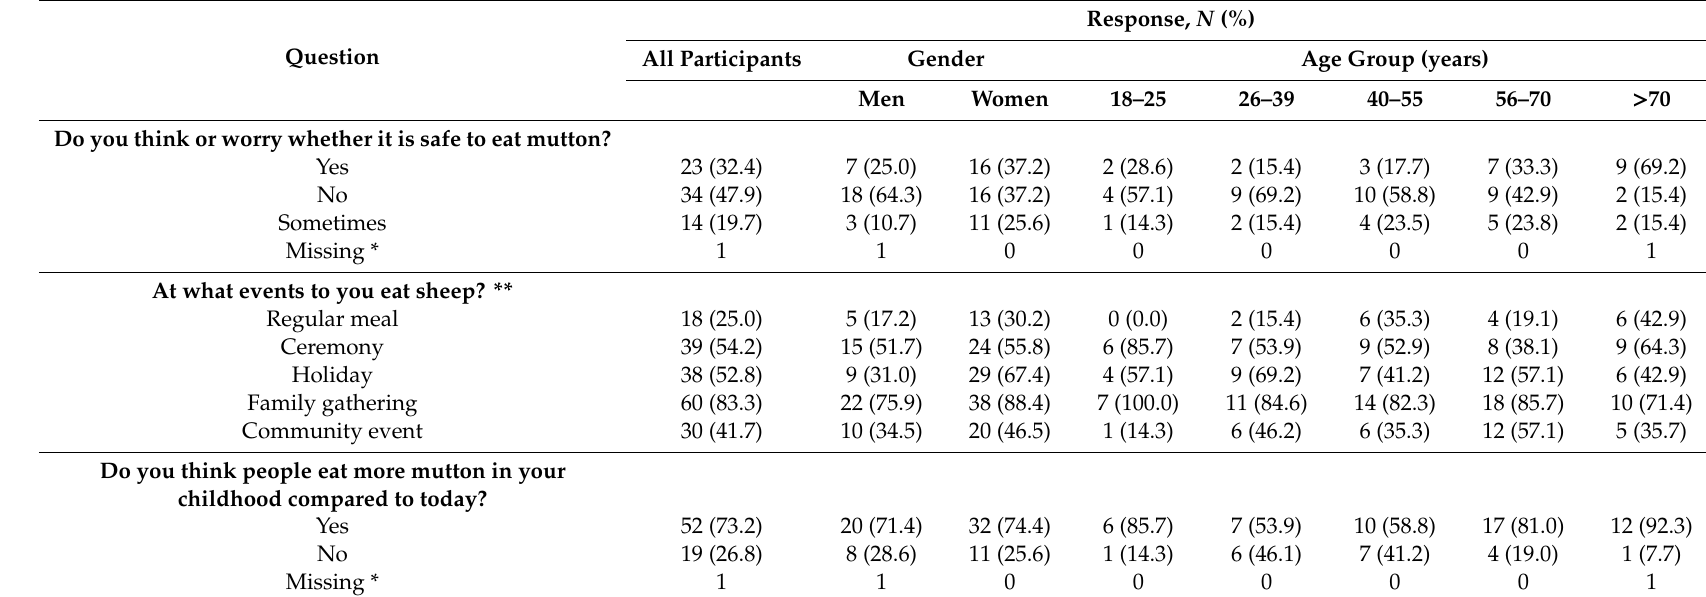
Table 3. Mutton eating habits among participants who completed the sheep survey, 2017 ( n = 72).